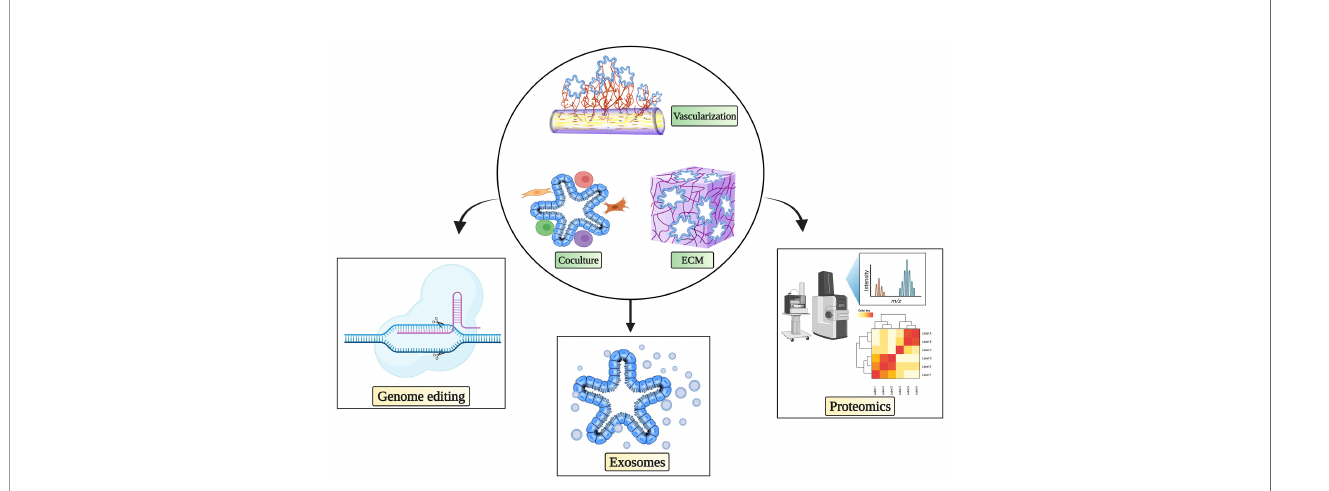
FIGURE 1 | Complex culture system and possibilities for tumor organoids in cancer immunotherapy research. Complex immune organoid culture systems including fi broblasts, various immune cells, and vasculature in addition to tumor organoids could be leveraged to serve as platforms for testing cancer immunotherapy. Various state-of-the-art technologies can be used in combination with complex tumor organoid culture systems to propel precision medicine. The fi gure was generated on